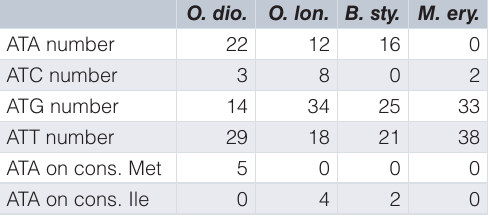
ATA on cons. Ile